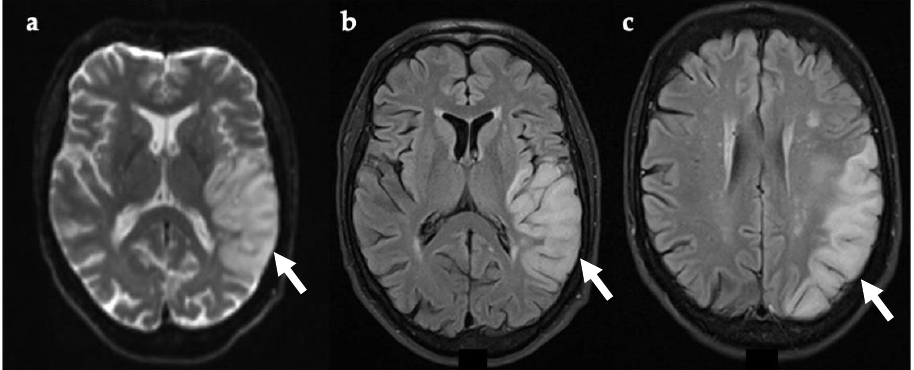
Figure 3. Axial brain MRI 24 h ( a , b ) and seven days ( c ) after symptom onset. Evidence of restricted diffusion in left temporal lobe (DWI) ( a , white arrow). T2-FLAIR showing cortical and gyral swelling in left temporal lobe ( b , white arrow). Image ( c , white arrow) was taken seven days after symptom onset and shows extension of lesion on the left occipital lobe. Abbreviations: DWI, diffusion-weighted imaging; FLAIR, Fluid attenuated inversion recovery imaging.